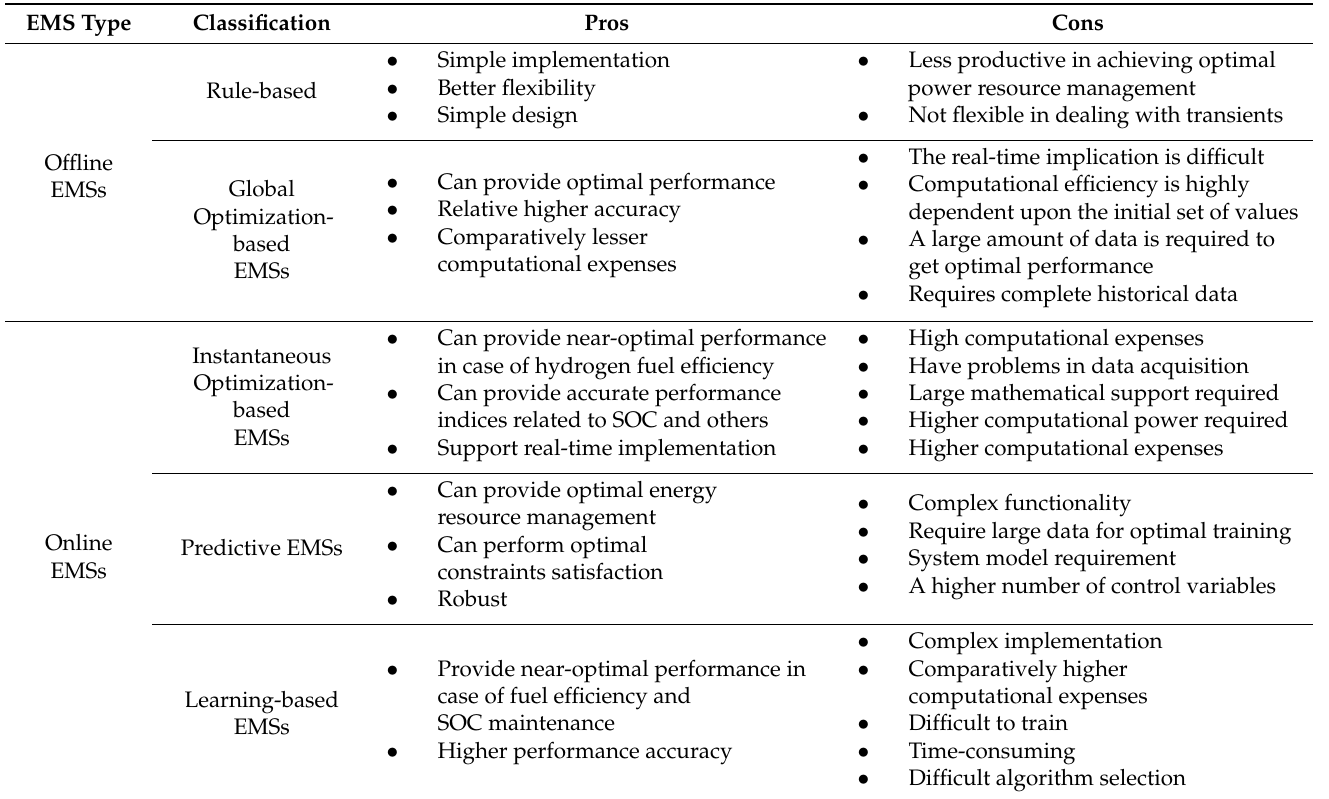
Table 14. Comparative analysis of the frequently used EMS